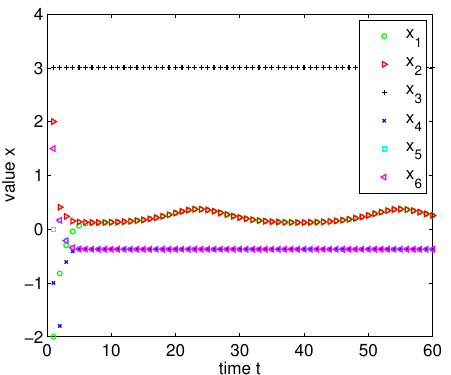
Figure 3. Time evolution of the agents’ values, where v 3 forwards different values to its neighbors, viz. ( t ) = 2 and x 4 ( t ) = 2 x ( t ) x 2 4 3 3